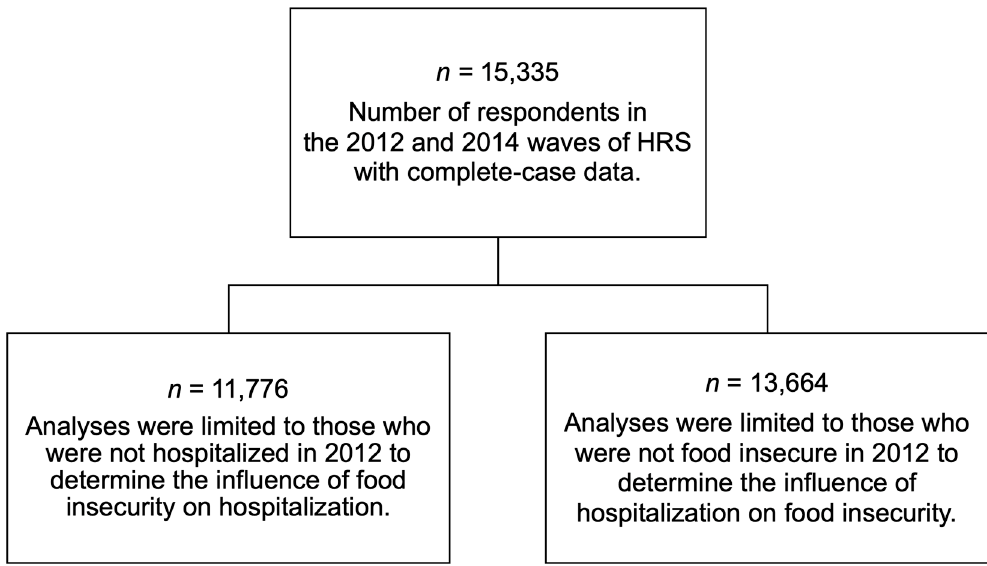
Figure 1. Flow chart for analytical samples within the 2012 and 2014 waves of the Health and Retirement Study (HRS).